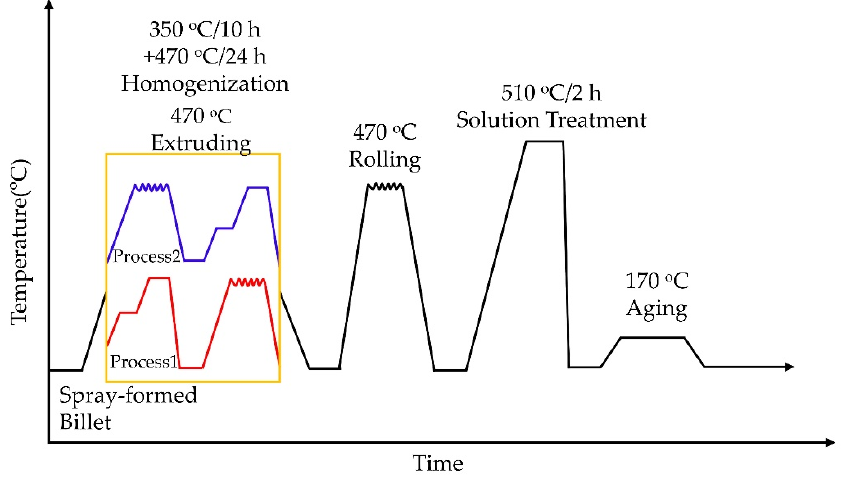
Figure 1. Process sketch of ( a ) P1: homogenization–extrusion and ( b ) P2: extrusion–homogenization before rolling–solution treatment.